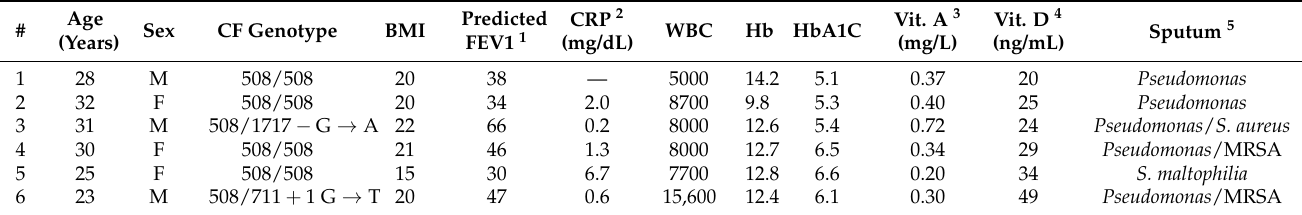
Table 1. CF participant